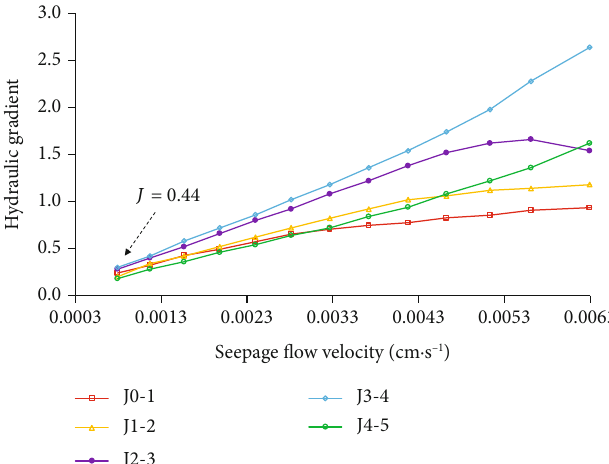
Figure 14: Process curve between hydraulic gradient and seepage fl ow velocity of di ff erent parts in soil numbered 2.